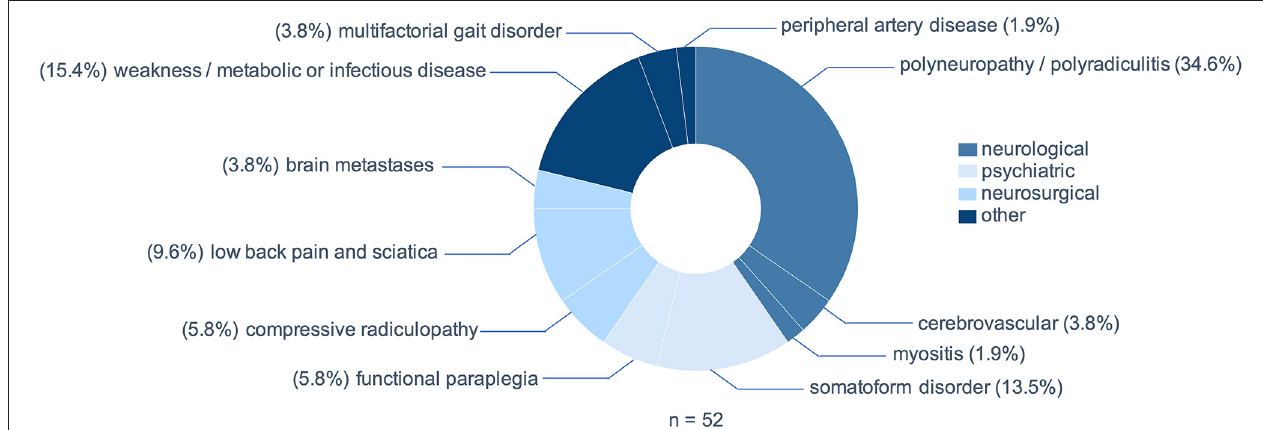
FIGURE 3 | Myelopathy mimics: underlying pathologies.